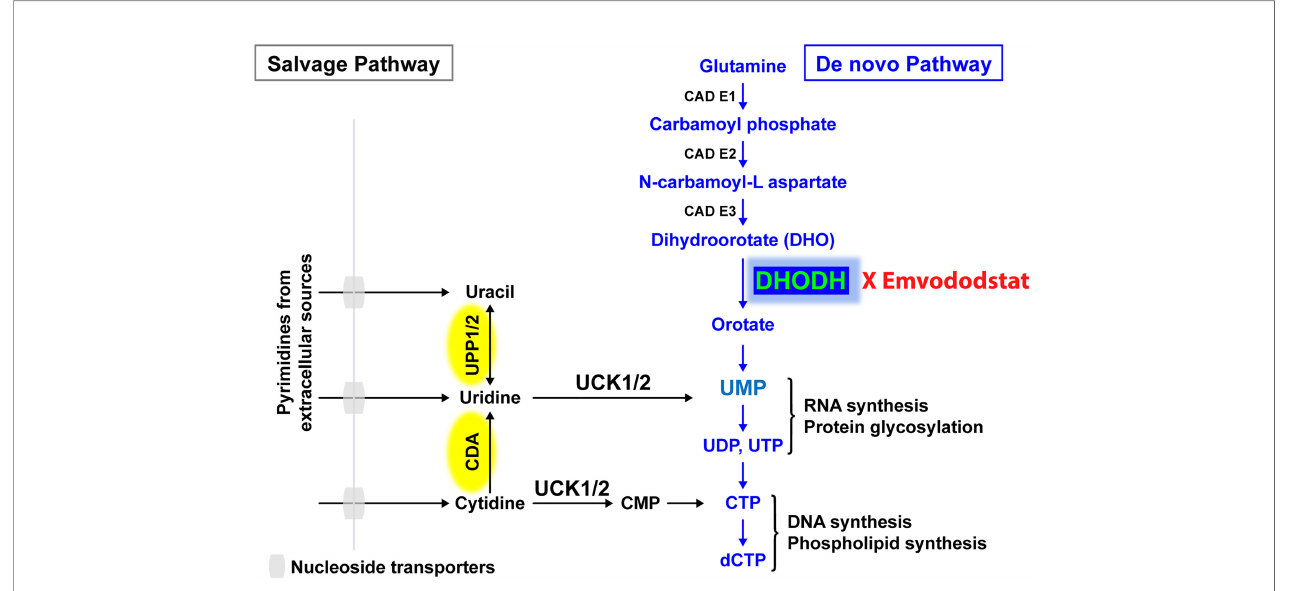
FIGURE 1 | The salvage pathway recycles pre-existing nucleotides from food or other extracellular sources. In rapidly proliferating cells such as AML blast cells, the salvage pathway is not suf fi cient. Adapted from